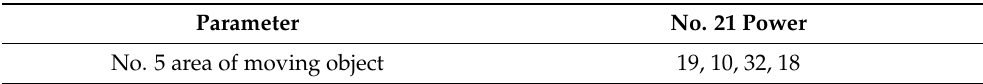
Table 6. Contradiction matrix table of Plan